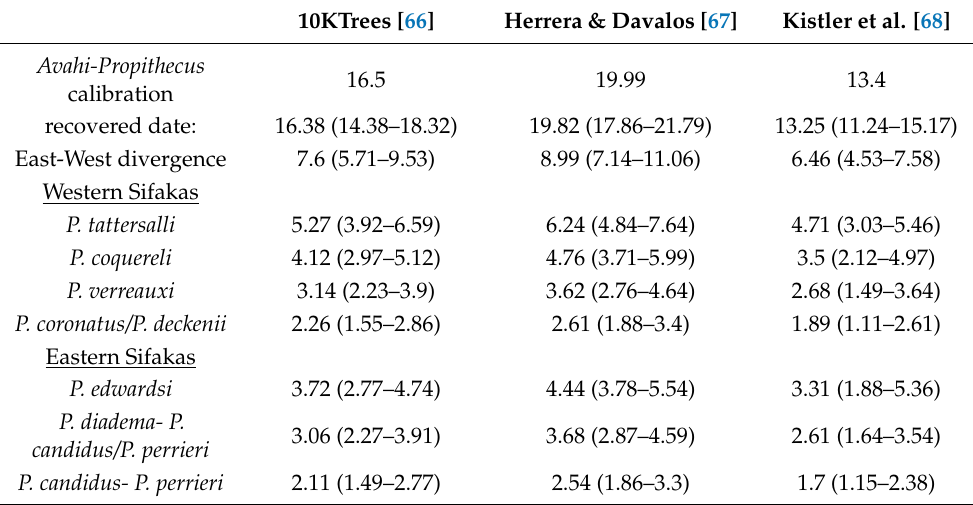
Table 2. Divergence date comparisons with three different age constraints for the Avahi–Propithecus split [66–68]. Node age is shown with 95% HPD in parentheses, and all ages are shown in millions of years.